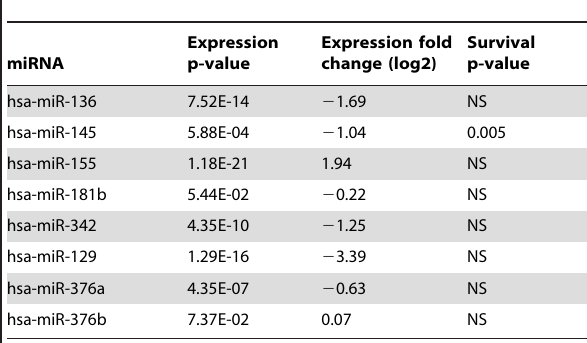
Table 1. Significant differences in miRNA expression of the functionally relevant miRNAs in clinical GBM tumor samples (n=308) compared to normal brain (n=9) from the TCGA GBM dataset as analyzed with the Anduril tool